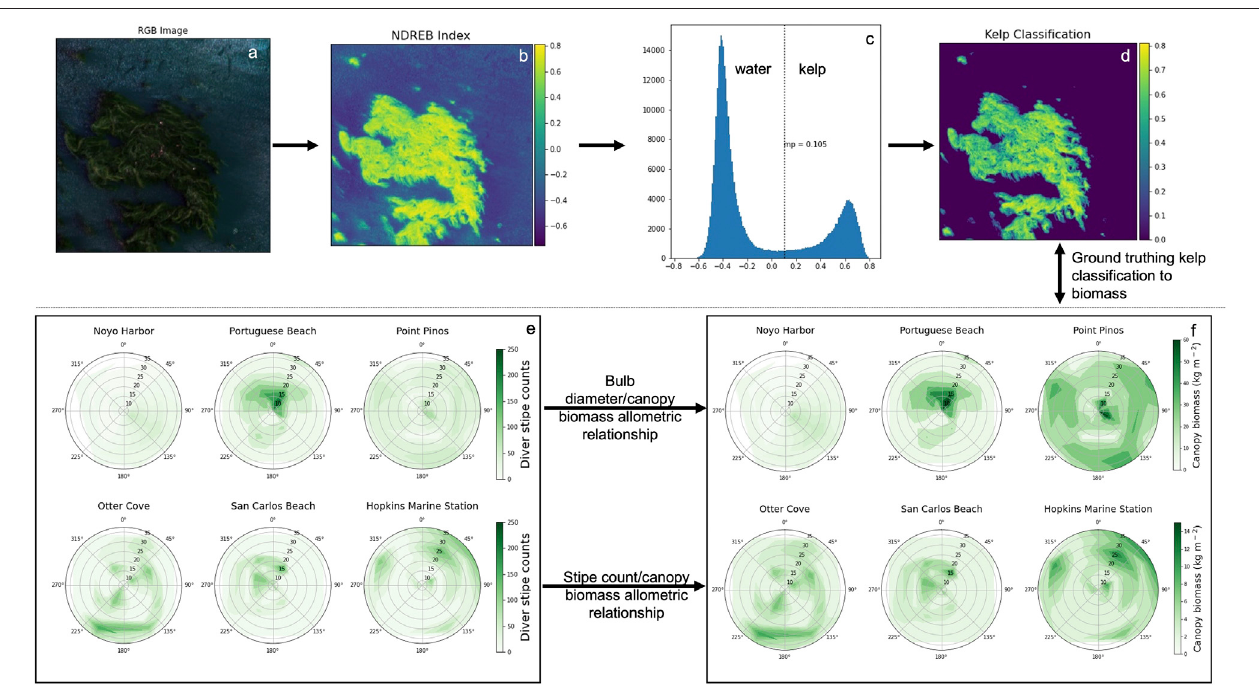
FIGURE 3 | A fl ow chart of the methodology used in the detection of kelp in each 10 cm pixel (top panel) and deriving in situ kelp canopy biomass via diver and morphometric surveys (bottom panel).